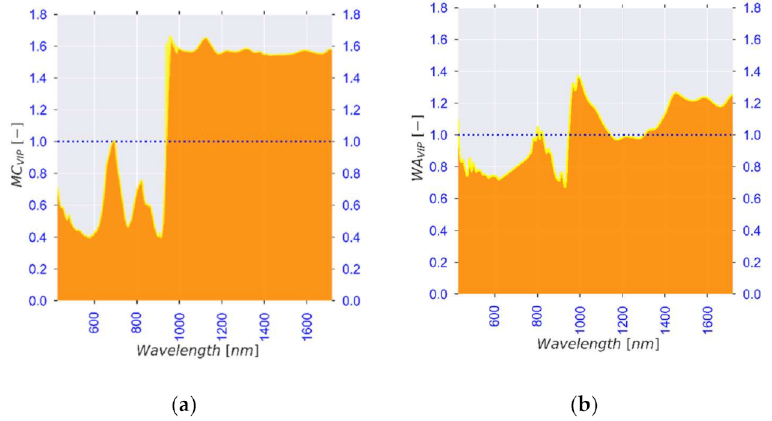
Figure 5. VIP plots for ( a ) moisture content and ( b ) water activity.